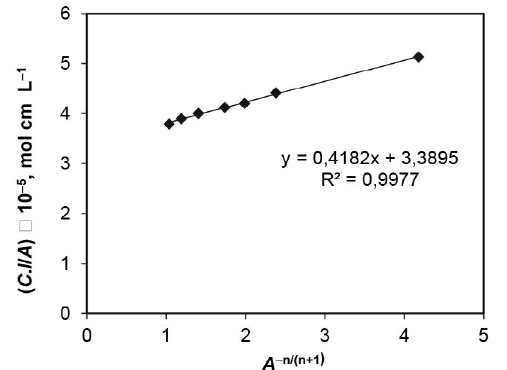
Figure 6. Dependency of ( C.l/A ) on A ‒n/(n+1) (method of Komar– Tolmachev) ; C = C Ge(IV) mol L –1 ; C TV = 2 C Ge(IV) mol L –1 ; C 4-NC =